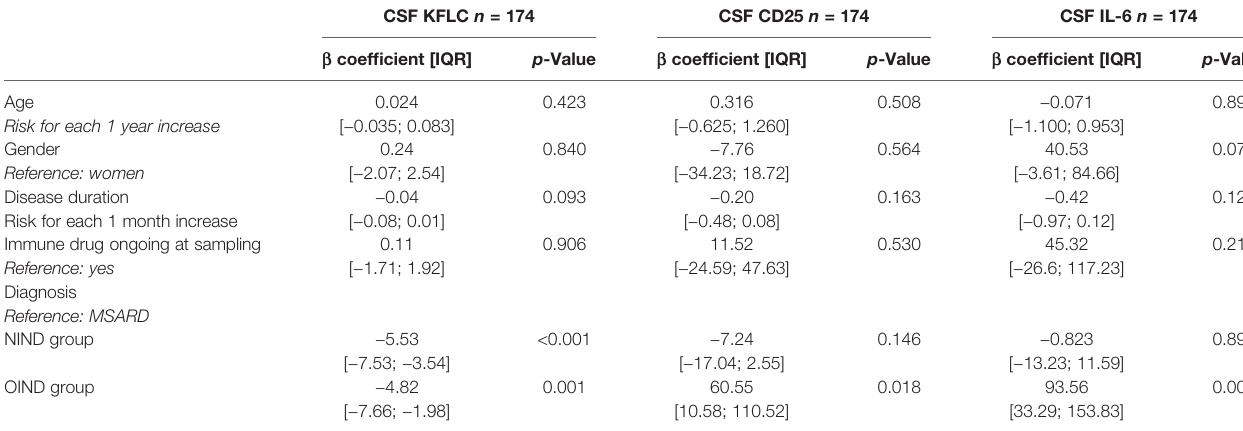
TABLE 5 | Identi fi cation of clinical and demographic data in fl uencing CSF KFLC, CSF CD25, and CSF IL-6 concentrations by linear regression multivariate